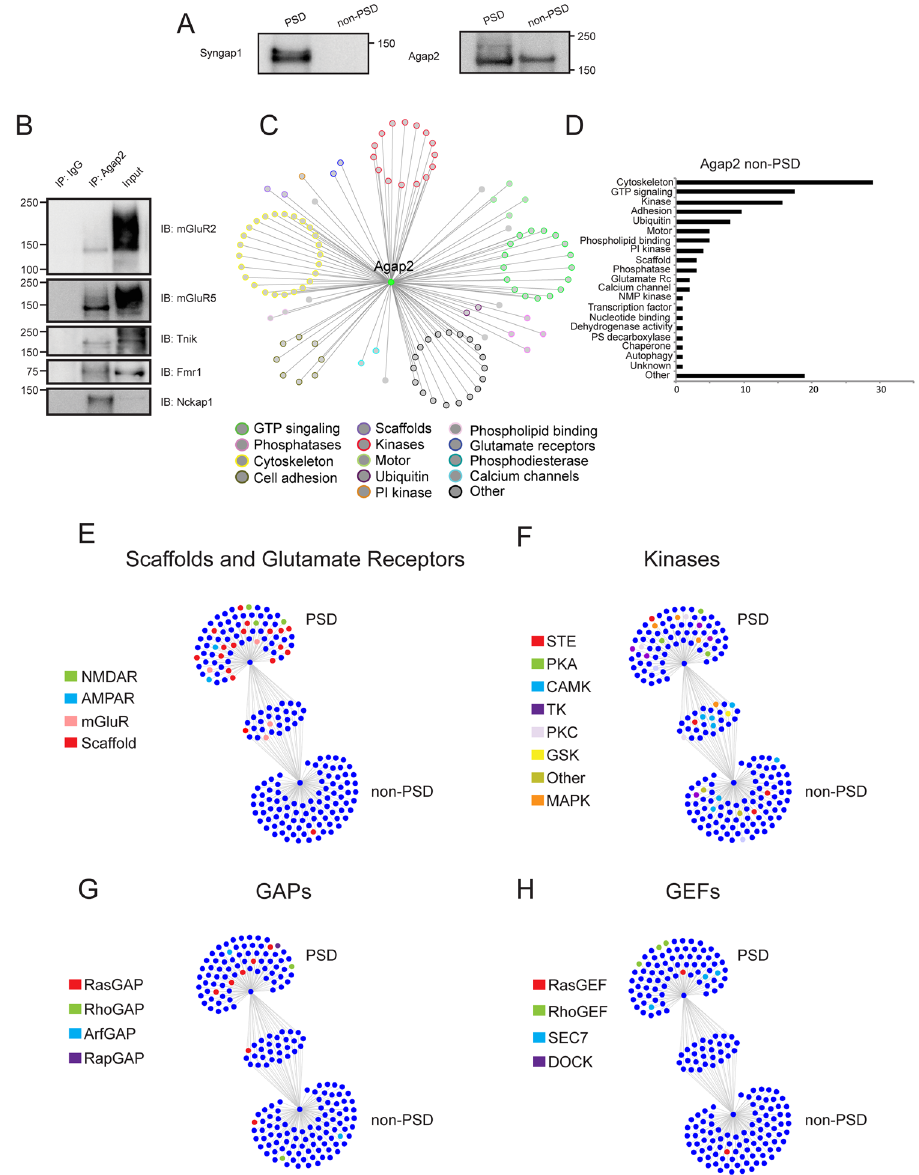
Figure 4. Differential Interactions and Functions of PSD vs Non-PSD Agap2. ( A ) Cropped images of immunoprecipation followed by western blot of Syngap1 and Agap2 post PSD enrichment in adult mouse cortex. Syngap1 is restricted to the PSD fraction while Agap2 is present in both PSD and non-PSD fractions. ( B ) Cropped images of immunoprecipitation followed by western blot for interactors of Agap2 in non-PSD fractions that were identified via HPLC-MS/MS. ( C ) Non-PSD Agap2 interactome clustered by protein function. ( D ) Quantitation of Agap2 interactome by protein function. ( E – H ) Comparison of Agap2 PSD interactome versus Agap2 non-PSD interactome illustrating the distributions of ( E ) scaffolding proteins and glutamate receptors, ( F ) Kinases, ( G ) GAPs, and ( H ) GEFs. Abbreviations: CAMK, Ca 2 + /Calmodulin- dependent protein kinase; GAP, GTPase activator protein; GEF, guanine nucleotide exchange factor; GSK, glycogen synthase kinase; MAPK, mitogen-activated protein kinase; SEC7, domain in homologues of S. cerevisiae Sec7; STE, homologs of Ste7, Ste11, and Ste20; TK, tyrosine kinase; PKA, protein kinase A; PKC, protein kinase